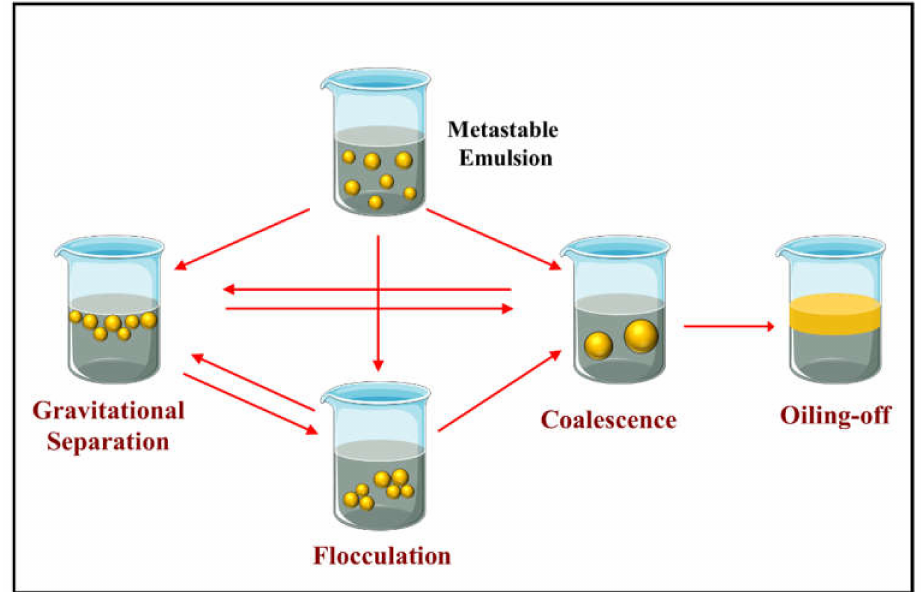
Figure 7. Schematic diagram of different physicochemical mechanisms that protein-stabilized oil- in-water emulsions may become unstable: gravitation separation, flocculation, coalescence, and